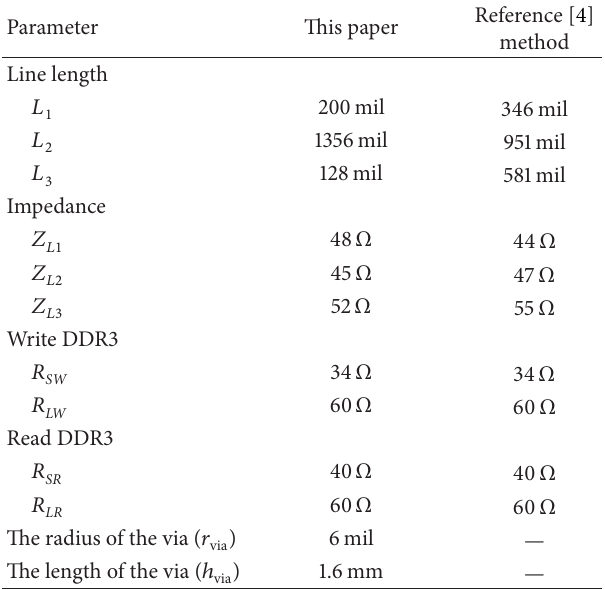
Table 4: The results of parameter optimization.